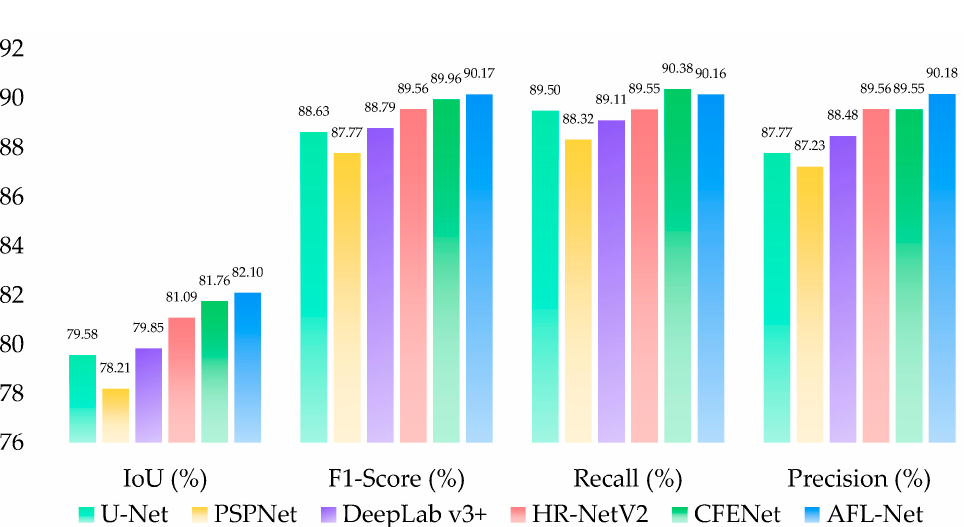
Figure 5. Comparative results from the selected models on the WHU dataset.